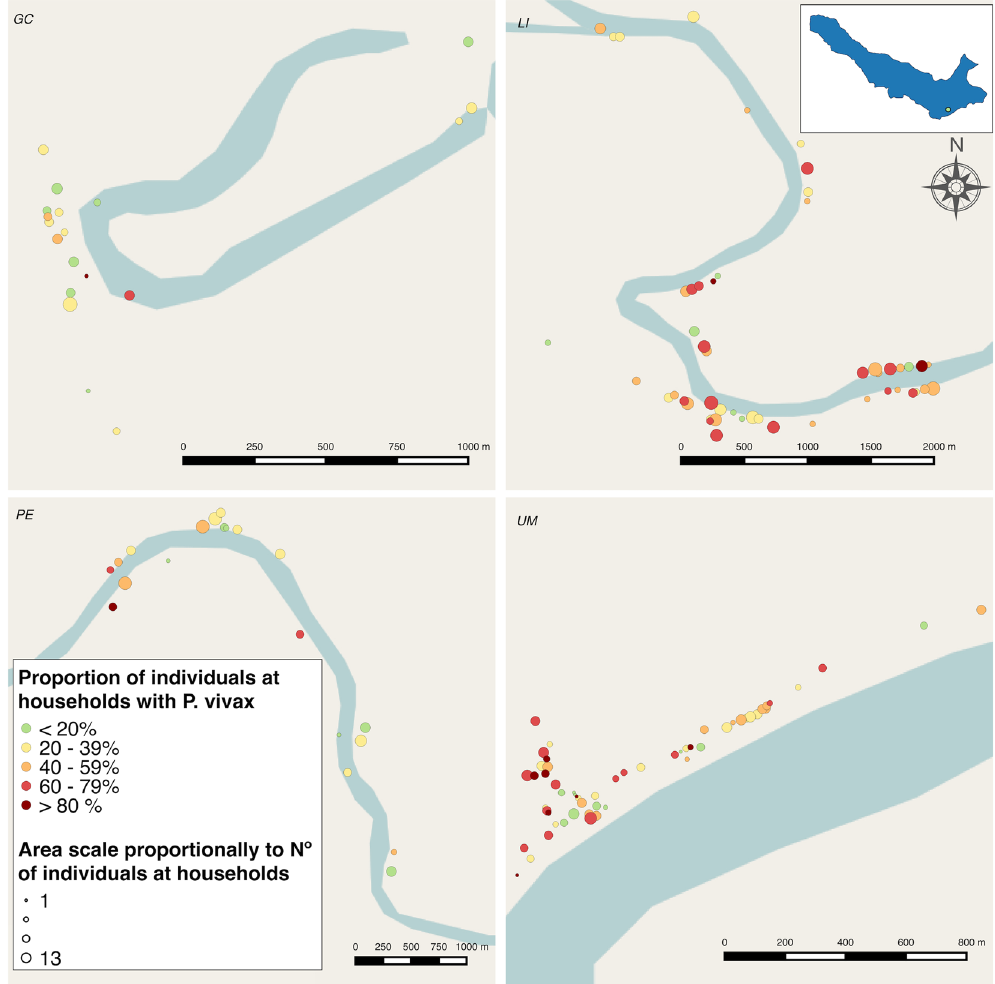
Figure 3. Proportion of participants per household with at least one P . vivax parasitaemia along the follow-up in: Gamitanacocha (GC), Libertad (LI), Primero de Enero (PE) and Urco Miraño (UM). Each point represents a household location. Map generated with QGIS 2.16 (QGIS Development Team, 2016. QGIS Geographic Information System. Open Source Geospatial Foundation Project.